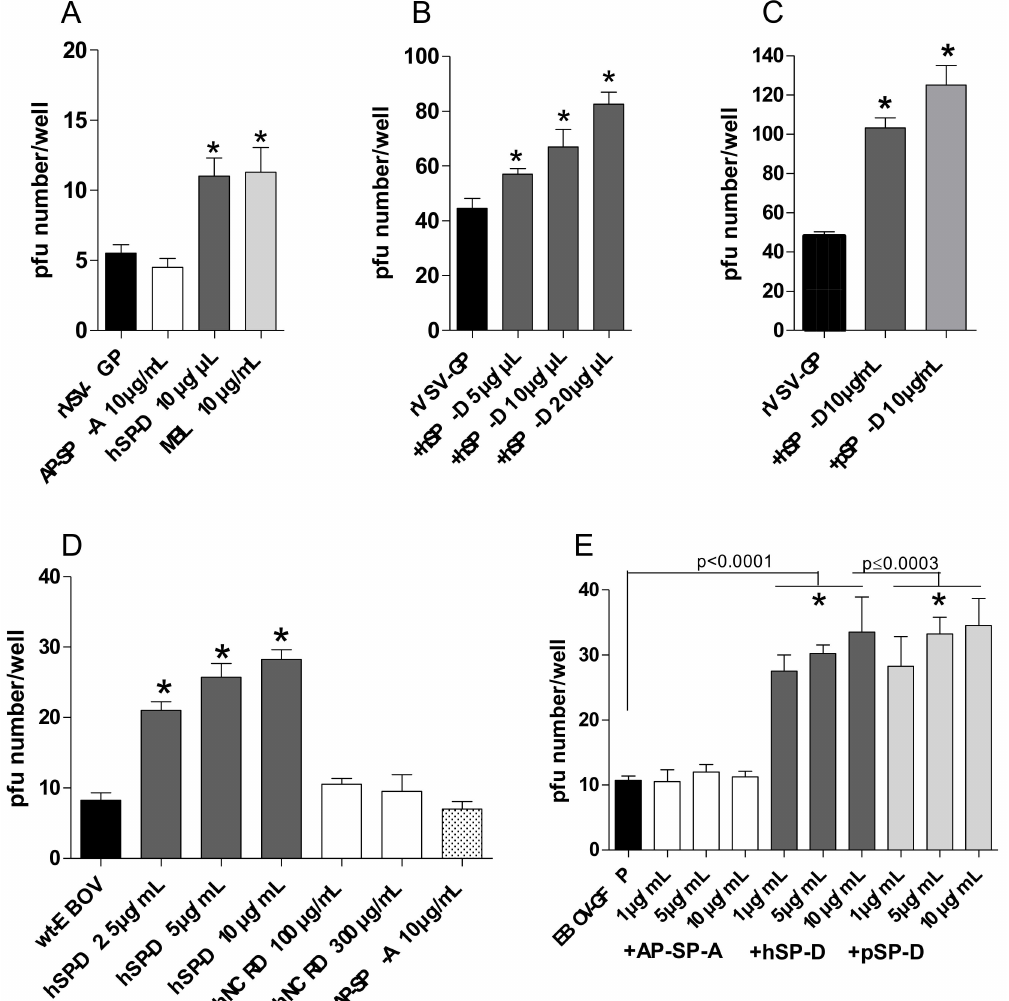
Figure 4. Enhancement of replicative-GP virus infection. wtVSV-G, rVSV-GP, and EBOV